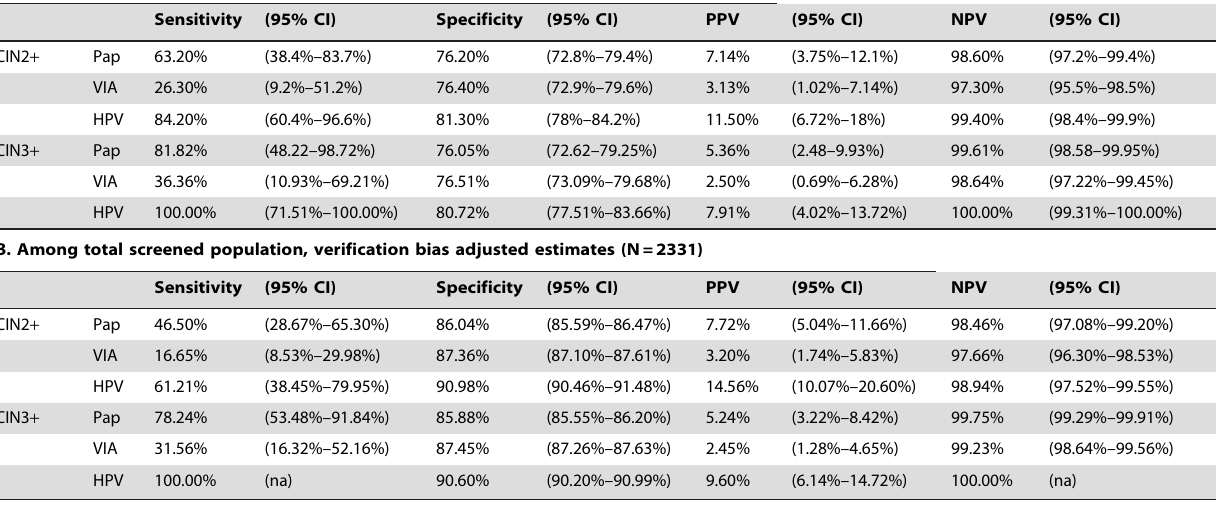
Table 3. Test performance